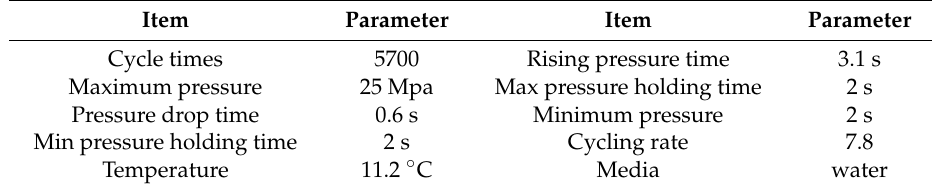
Figure 5. Parameters in hydraulic fatigue cycling. Table 1. Parameters of the hydraulic fatigue cycling.